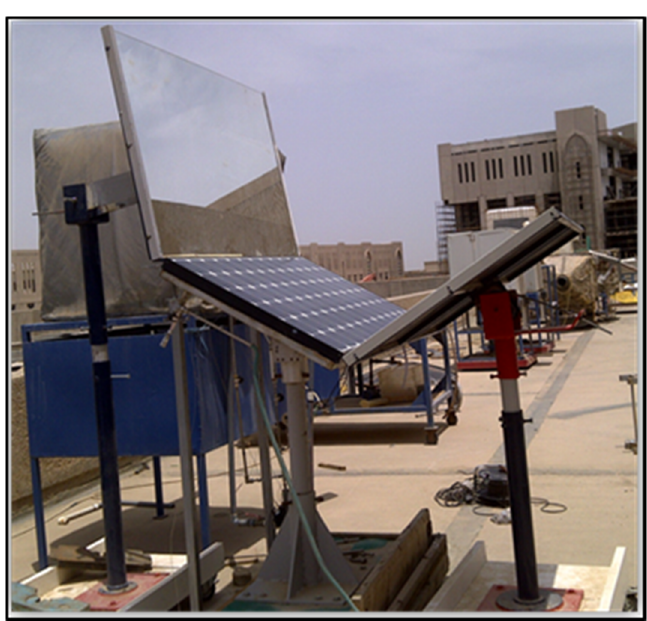
Figure 7. Experimental setup of V-trough PV